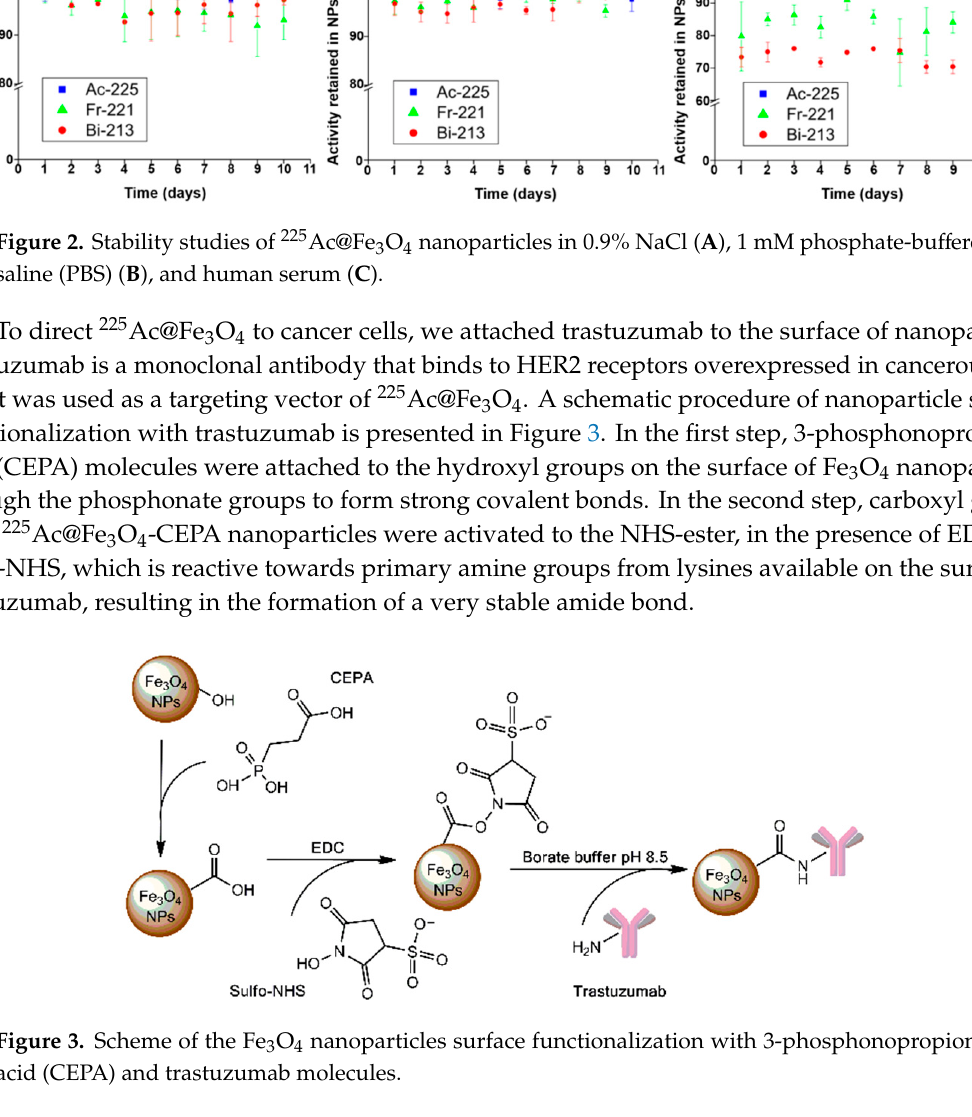
Table 1. The hydrodynamic diameters, polydispersity index (PDI) and zeta ( ζ ) potentials of bare